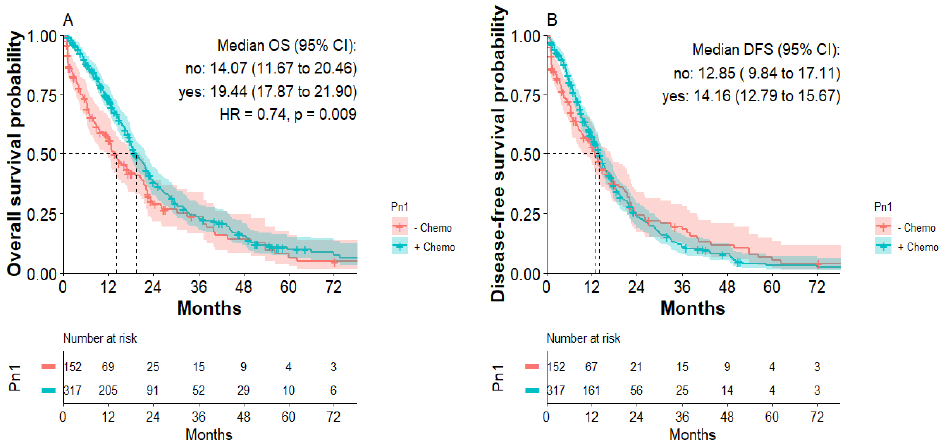
Figure 3. Overall survival and disease-free survival of patients with Pn1 tumors with or without postoperative chemotherapy. ( A ) Overall survival of Pn1 patients with or without postoperative chemotherapy. ( B ) Disease-free survival of Pn1 patients with or without postoperative